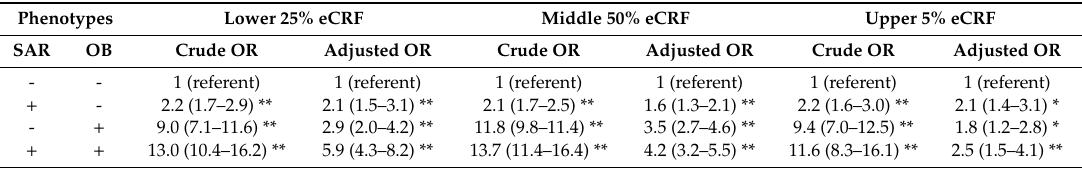
Table 3. Odds ratio (OR) of sarcopenia and obesity-based phenotypes for NAFL, stratified by eCRF levels (data are presented as OR and 95% confidence